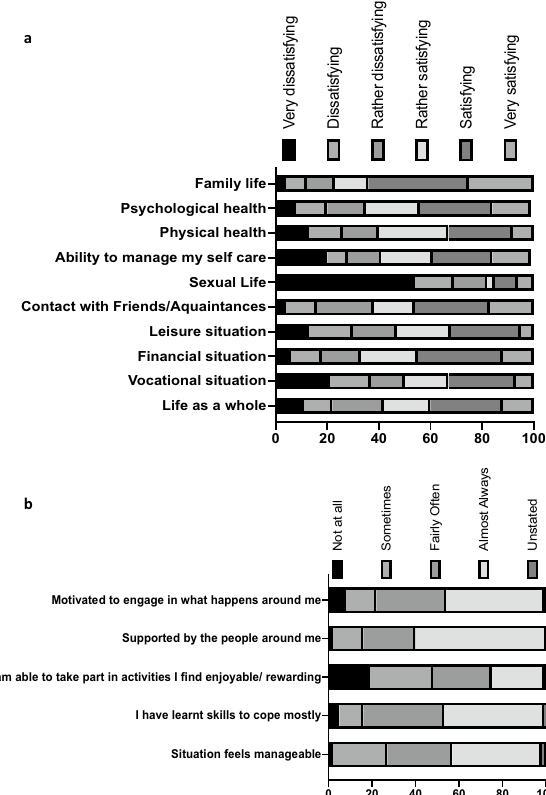
Figure 3. Participants’ responses on a Likert scale to questions about how they feel about their life in general. ( a ) Proportion of each response of the total number of responses about satisfaction with different aspects of life. ( b ) Proportion of different responses about how participants feel about their SCI.